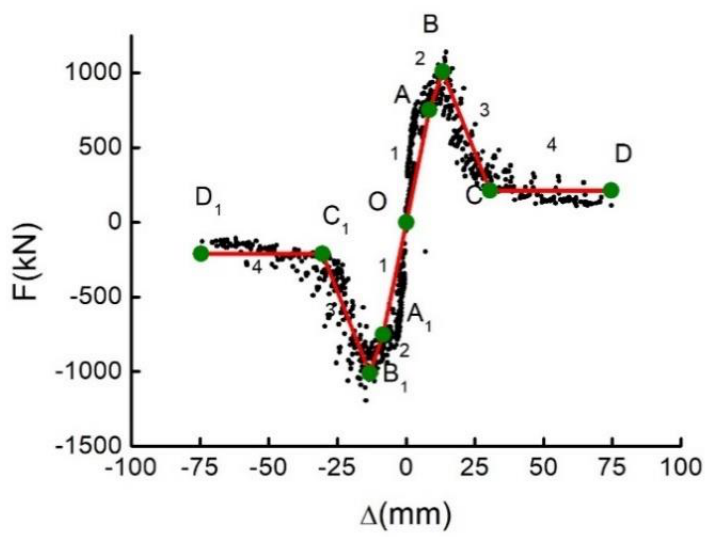
Figure 8. General skeleton curve obtained from fitting.